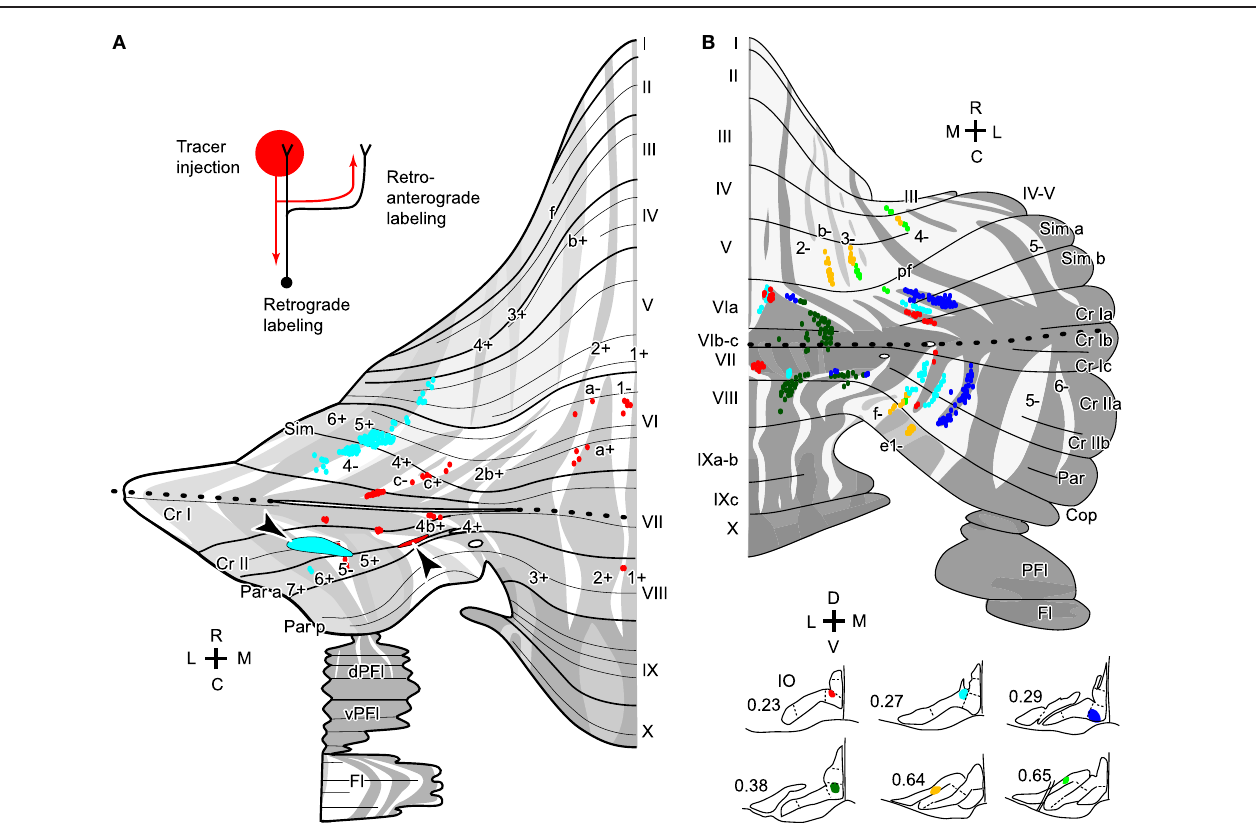
labeled CFs labeled by a small injection of biotinylated dextran amine into the mouse IO, mapped in the scheme of aldolase C compartments in the cerebellar cortex. Cases in which CFs were labeled in multiple mediolaterally separate compartments are summarized here, suggesting transverse branching. CFs are also distributed in longitudinally separate areas, suggesting longitudinal branching. Single axons were not reconstructed. (A) and (B) are based on the data in Fujita et al. (2010) and Sugihara and Quy (2007), respectively. Dotted lines indicate the rostrocaudal